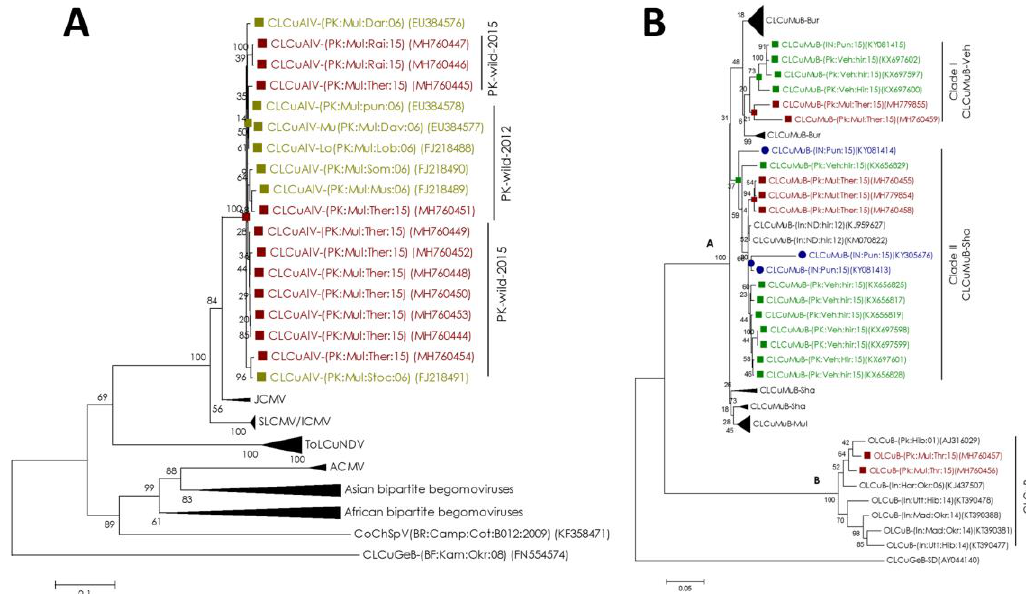
Figure 3. Phylogeny of DNA-B component of bipartite begomoviruses and betasatellites. ( A ) Neighbor-joining (NJ) phylogenetic dendrogram of cotton leaf curl Alabad virus (CLCuAlV) DNA-B reported in this study (group named as “PK:wild:2015”) and other related bipartite begomoviruses. Other representative sequences (from Asia, Africa and South America) have been included in the phylogenetic analysis but has been compressed in the final figure for better representation. ( B ) Phylogenetic dendrogram of betasatellites reconstructed with cotton leaf curl Multan betasatellite (CLCuMuB) and okra leaf curl betasatellite (OLCuB) found in the current study with other related sequences. Some CLCuMuB branches representing different strains (that are irrelevant to the scope of current study) have been collapsed to avoid complexity. All the sequences reported in this study are colored maroon with solid maroon squares and closely related betasatellite sequences isolated from Pakistan and India (2015) from cultivated cotton ( G. hirsutum ) are colored green and blue respectively. Sequences reported from the pioneer study on non-cultivated cotton species [31] have been represented by solid olive squares and olive text (group named as PK:wild:2012). Begomovirus and betasatellite species names have been abbreviated according to the standard nomenclature [32] and CLCuMuB strains have been assigned names as described earlier [10]. Both dendrograms are supported by 1000 bootstrap value and were arbitrarily rooted with cotton leaf curl gezira leaf curl betasatellite (CLCuGeB) as an outgroup.